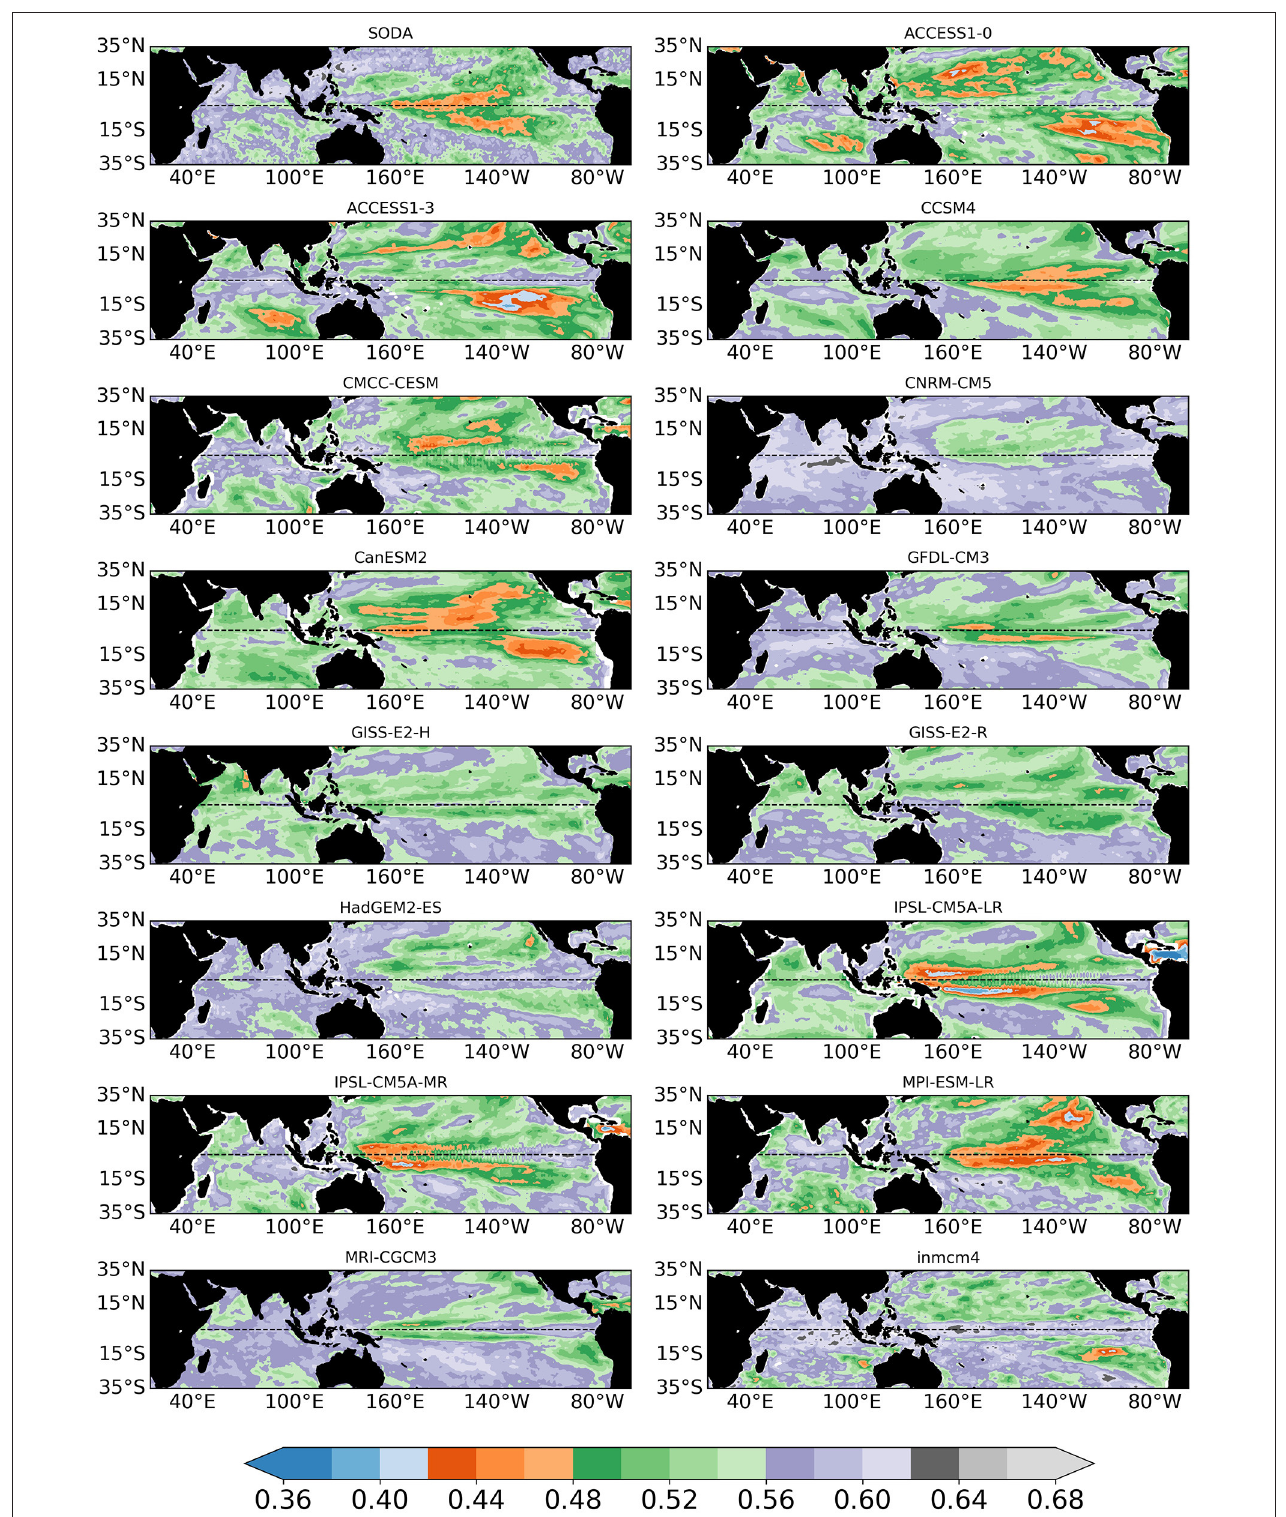
FIGURE 3 | Boreal spring (March–April–May) SST entropy fields with microstates, M = 3 during 1967–2005 for models and during 1980–2018 for SODA reanalysis.